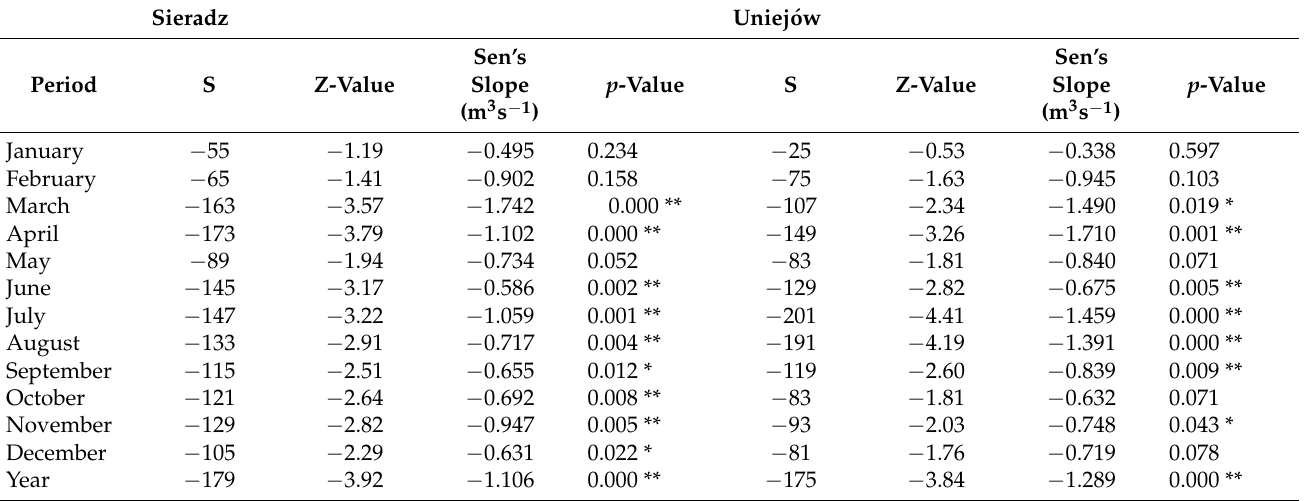
Table 5. Changes in mean monthly and annual water flows in hydrological stations Sieradz and Uniej ó w in the period 1995–2021.